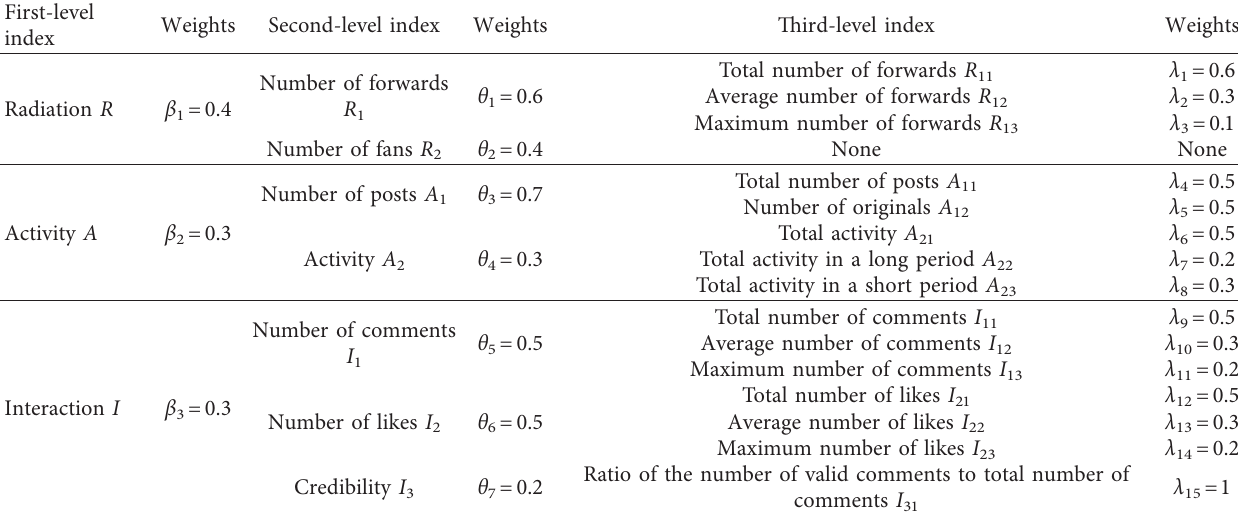
Table 1: Temperature and wildlife count in the three areas covered by the